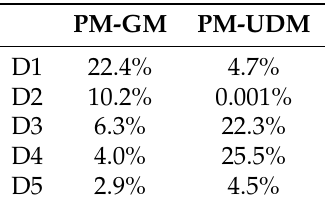
Table 3. Difference of average overall accuracy (from 1% to 30% of labeled data) between the Personalized Model and the other two models. PM: Personalized model; GM: General model; UDM: User-dependent model.